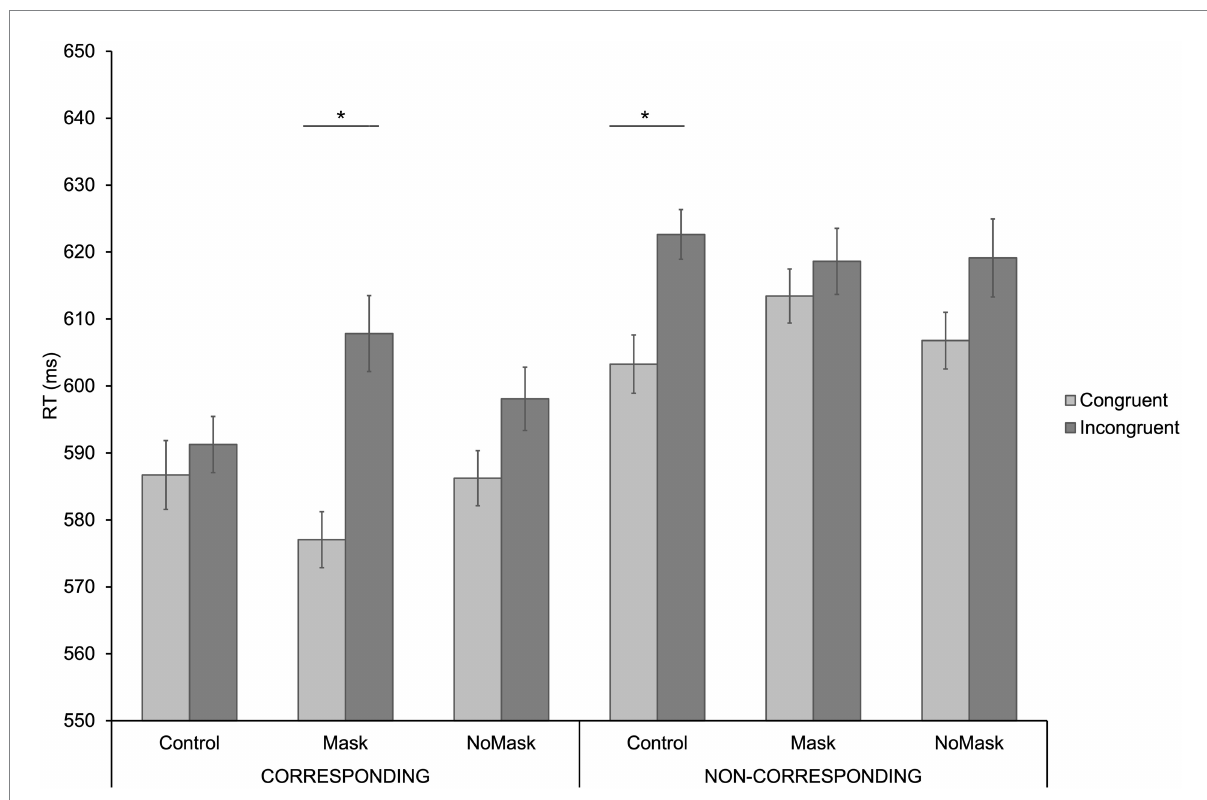
FIGURE 3 Mean reaction times (RTs) as a function of Condition and Congruence for Corresponding (leftmost panel) and Non-corresponding trials (rightmost panel). Error bars indicate standard errors of the mean adjusted for within-participants designs (Loftus and Masson, 1994). Asterisks denote significant differences.